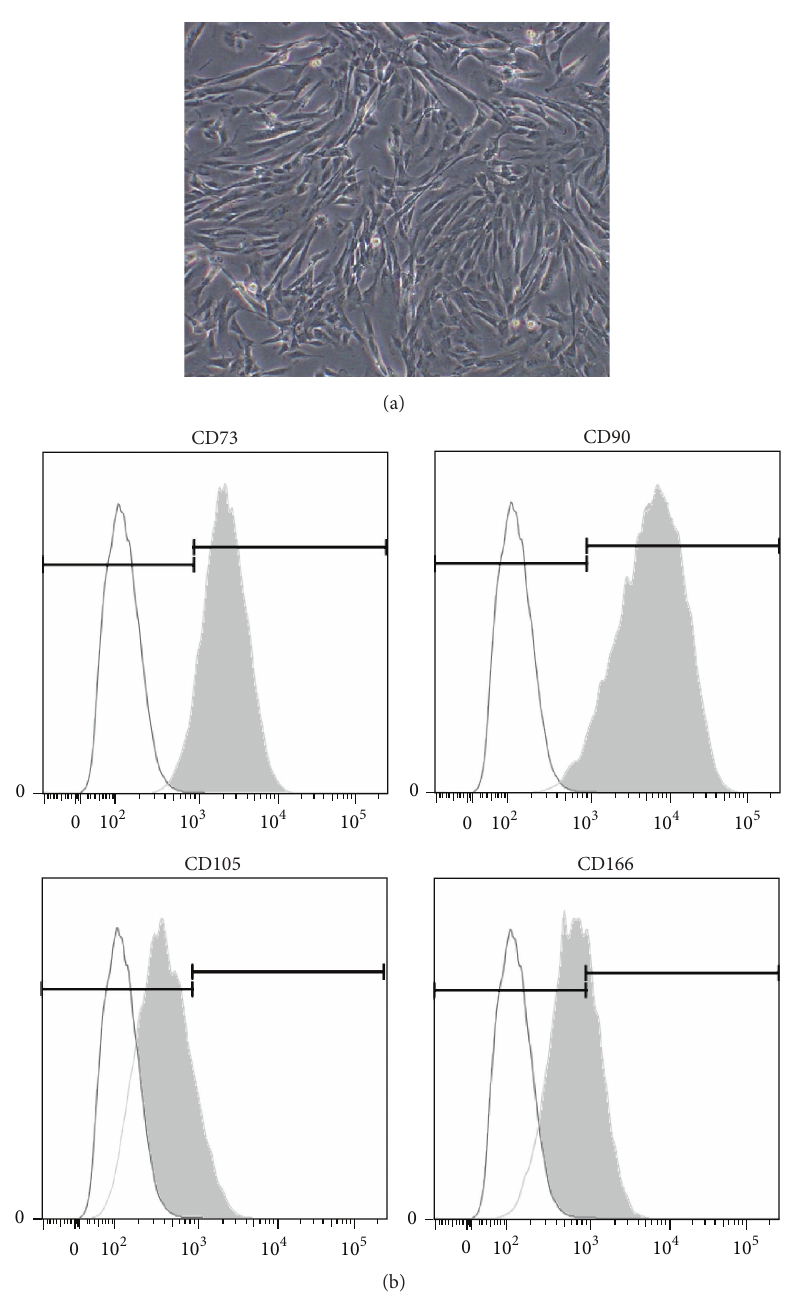
Figure 1: (a) A microscope image of cultured hDPSCs isolated from human primary teeth with no induction. (b) Positive expression of several cell surface antigens for mesenchymal stem cells, including CD73, CD90, CD105, and CD166, in hDPSCs. Similar cell surface antigen expression pattern was obtained with hDPSCs isolated from different donors (data not